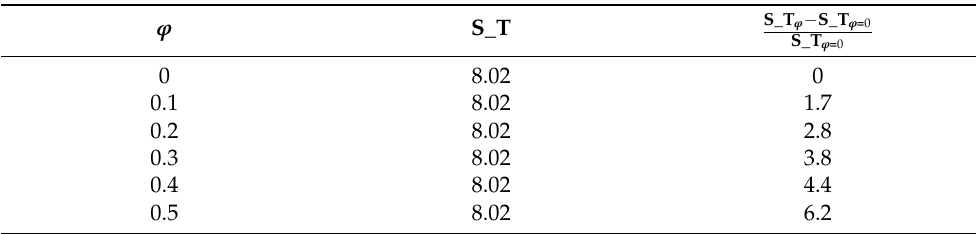
Table A2. The EGN for different volume percentages of silver eco-friendly N-Ps at Ra = 105, Ha = 0, and W = H =